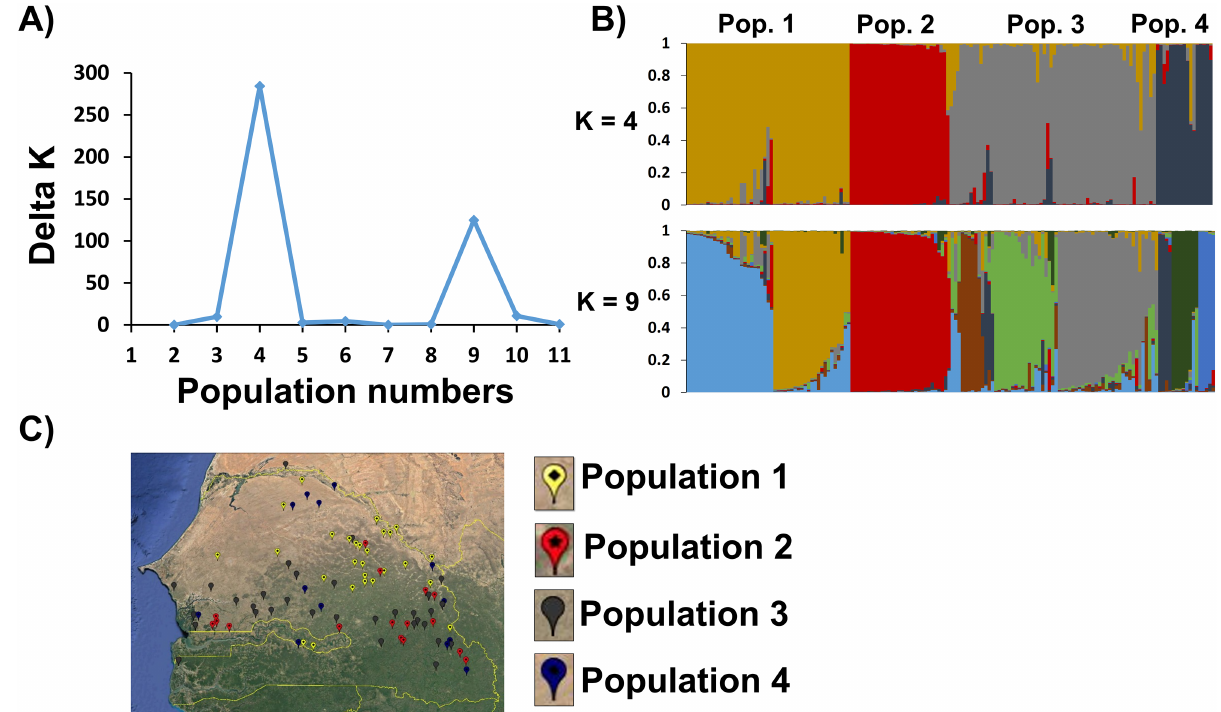
Fig 2. Population structure analysis of 158 NPGS Senegalese sorghum accessions. (A) The optimal number of populations was four based on the delta K method. (B) Hierarchical organization of the genetic relationships of the 158 Senegal accessions. (C) Collection sites of 107 Senegal accessions.